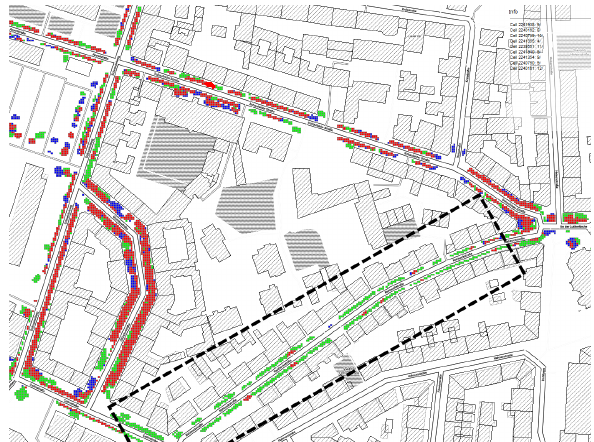
Figure 14. The usage before and after 12 am is encoded by different colors. Green: occupied before 12 am, blue occupied after 12 am, red occupied all the time. (basemap: Stamen Maps).